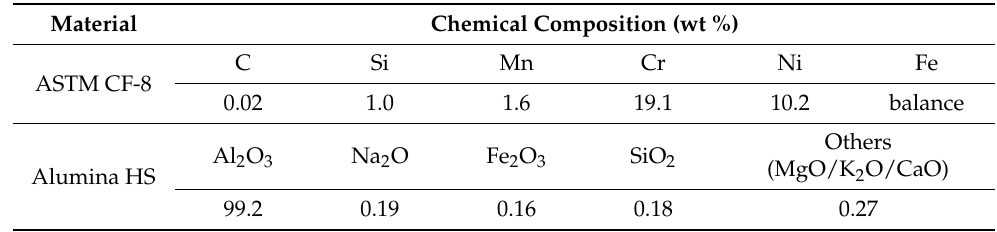
Table 1. Chemical composition of ASTM CF-8 cast austenitic stainless steel and alumina hollow spheres used in this work (in wt